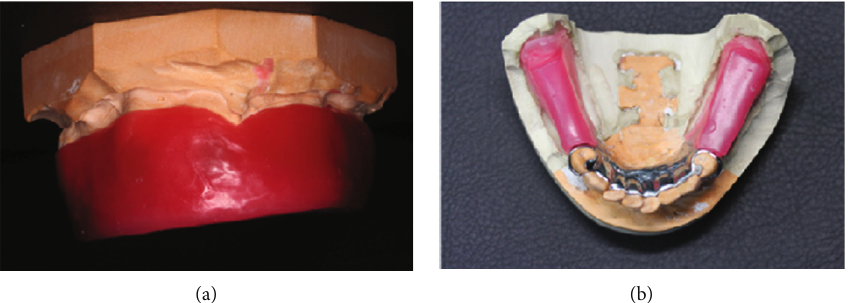
Figure 23: Occlusal rims for jaw relationship records.